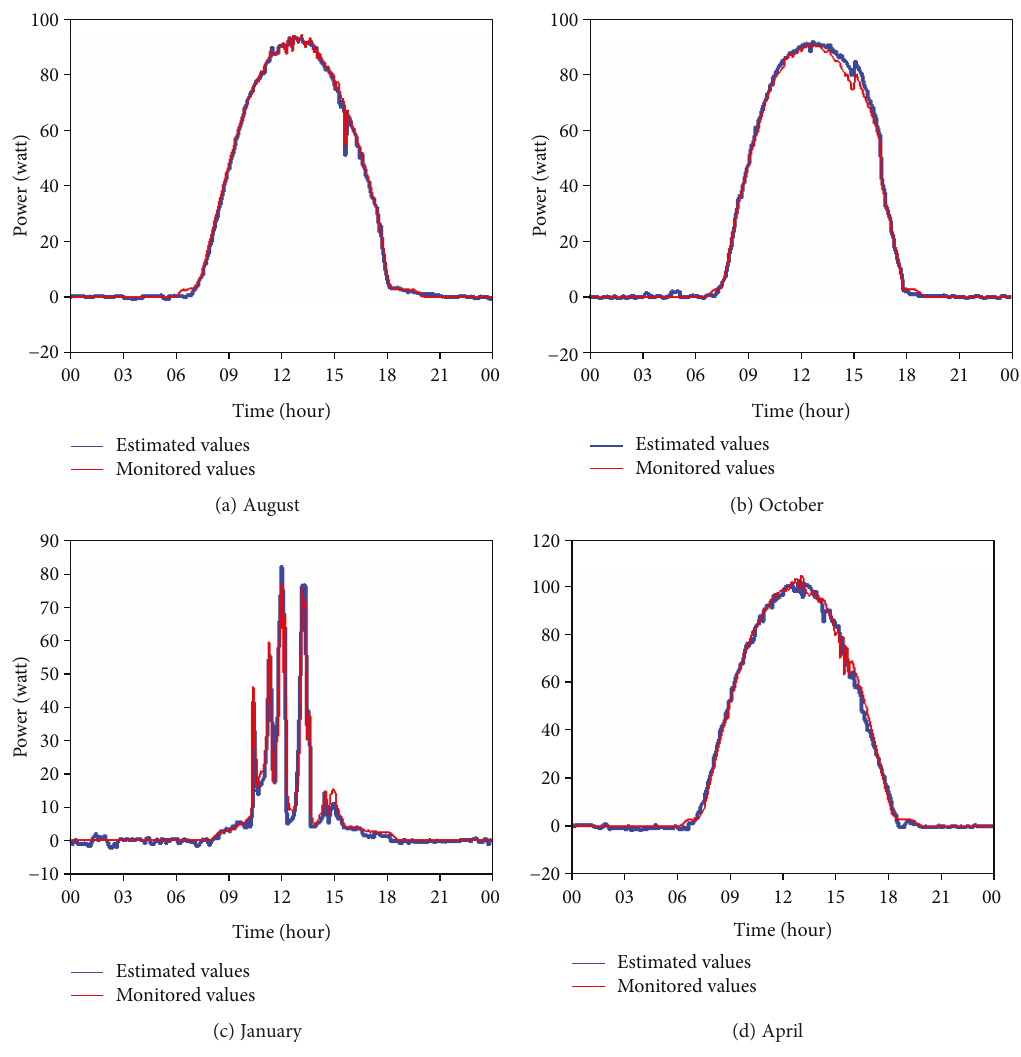
Figure 6: Sample estimation graphs for